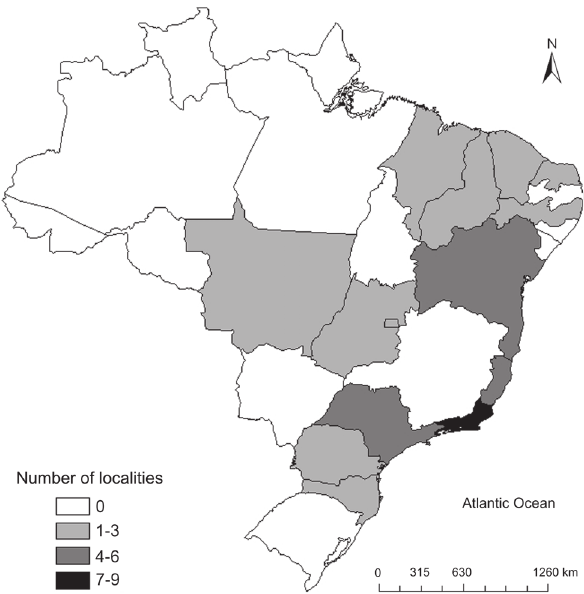
Figure 1. Map showing for each state of Brazil, the number of records of occurrence of the exotic gekkonid lizard Hemidactylus mabouia as an invader species in natural environments. The gra- dation of gray color intensities indicates the number of records for each particular